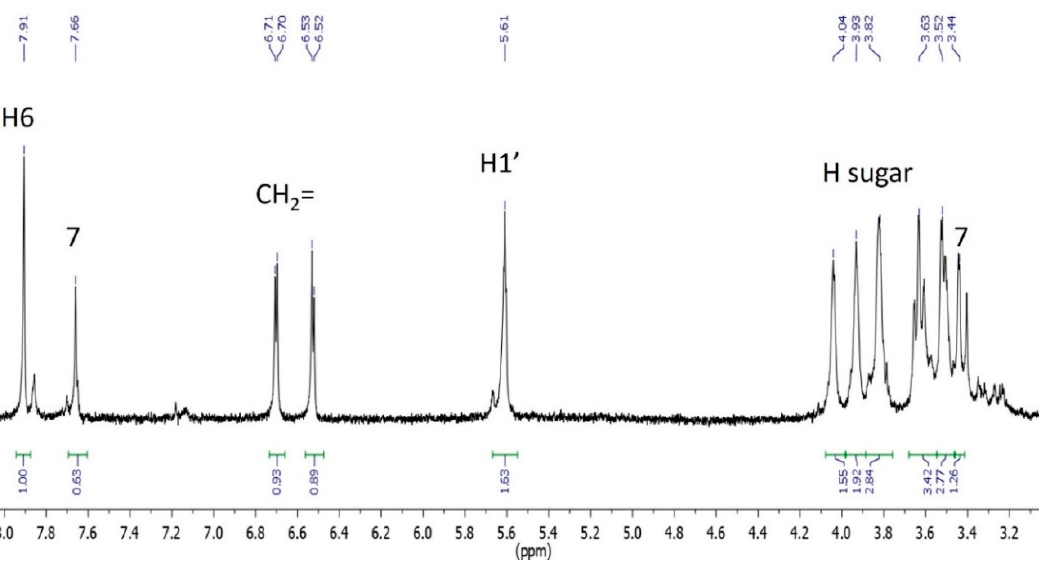
Figure 13. 1 H-NMR (600 MHz, 278 K) spectrum of isolated 2 in D 2 O. The tube contains a mixture of 2 (60%) and 7 (40%). The solvent peak at δ 4.7 ppm is absent.